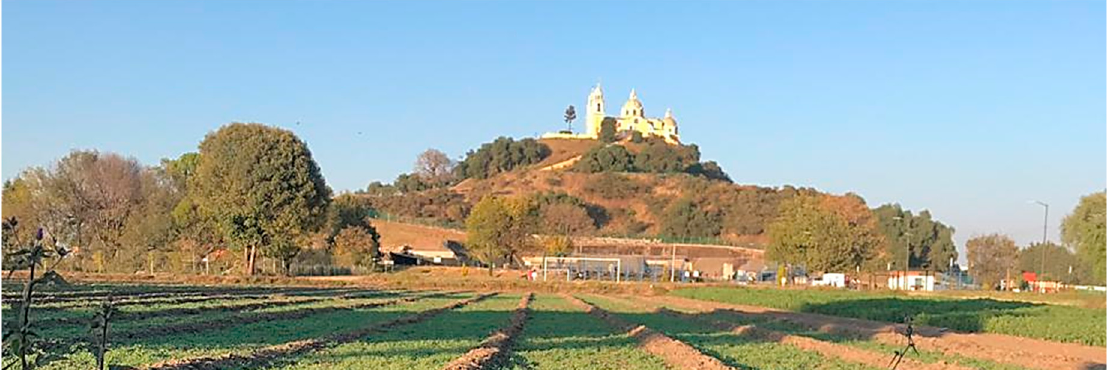
Figure 3. The Great Pyramid of Cholula “Tlachihualtépetl”, topped by the Sanctuary of la Virgen de los Remedios, and surrounded by the few remaining pre-Hispanic agricultural fields. Source: Schumacher M. (2019).